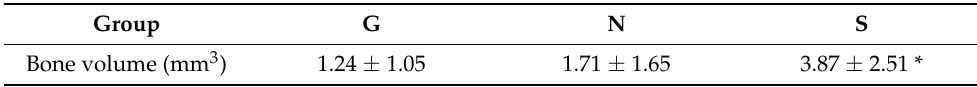
Figure 1. Microcomputerized tomogram (MicroCT) analysis. Scanned images were used for three-dimensional reconstruc- tions. The size of the primary surgical defect was referenced as the region of interest (G: gelatin only group, N: unfilled control group, S: sericin combined with gelatin group). Table 1. Bone volume in region of interest measured by microCT.